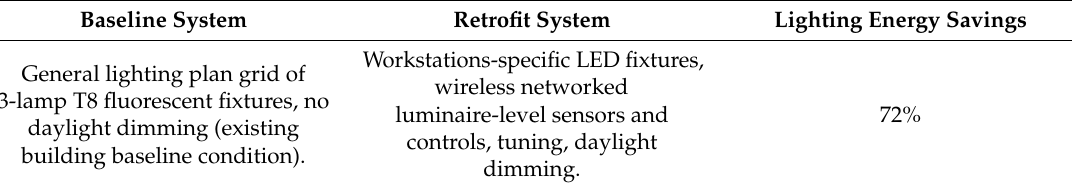
Table 6. Test System 3 characteristics and energy